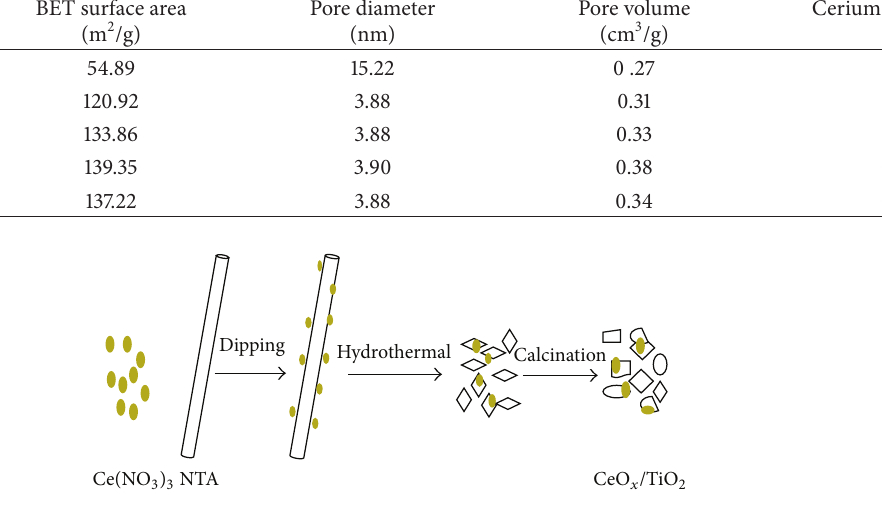
Table 1: Effect of surface area, pore diameter, pore volume and cerium atom content of CeO 𝑥 /TiO